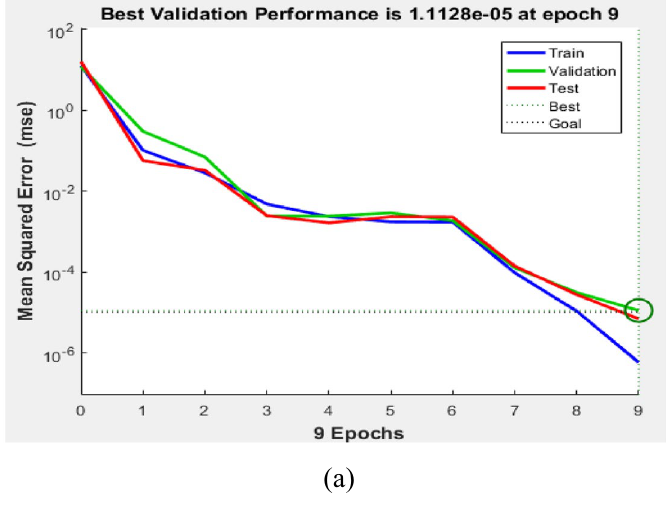
Figure 13. Training results. ( a ) Model training MSE. ( b ) Correlation coefficient of GA-BP